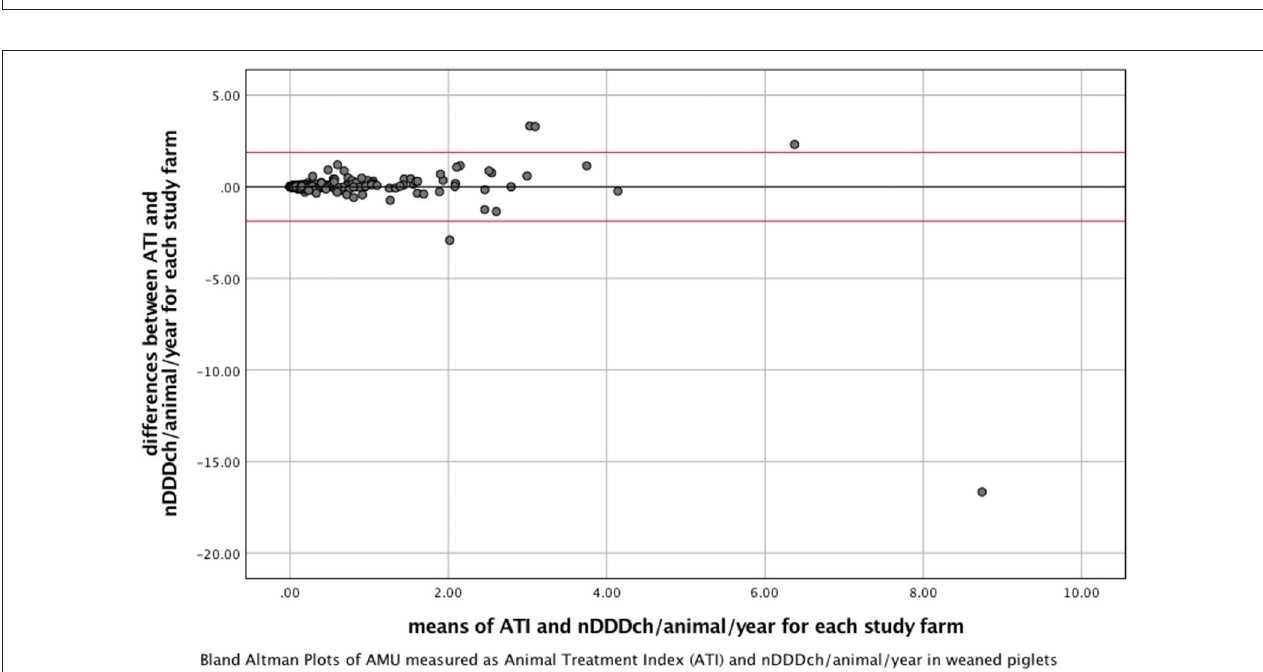
FIGURE 2 | Scatterplots and linear regression of AMU calculated either as Animal Treatment Index (ATI) or the number of DDDch/animal/year (nDDDch/animal/year) for gestating sows from 319 study farms.